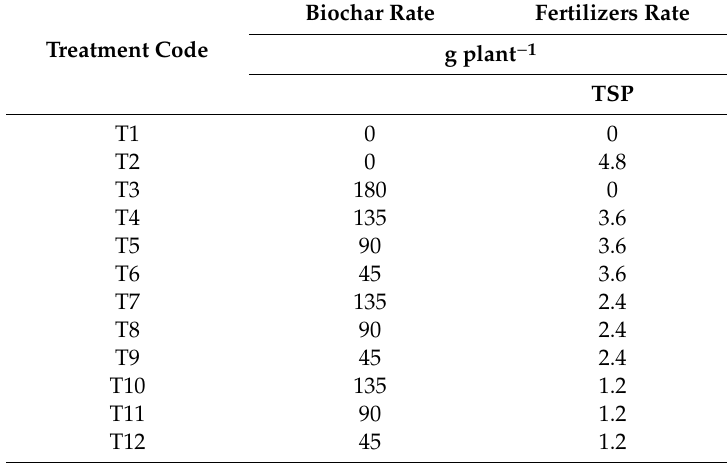
Table 2. Scale down of chicken litter biochar, nitrogen, phosphorus, and potassium fertilizers rate in a pot